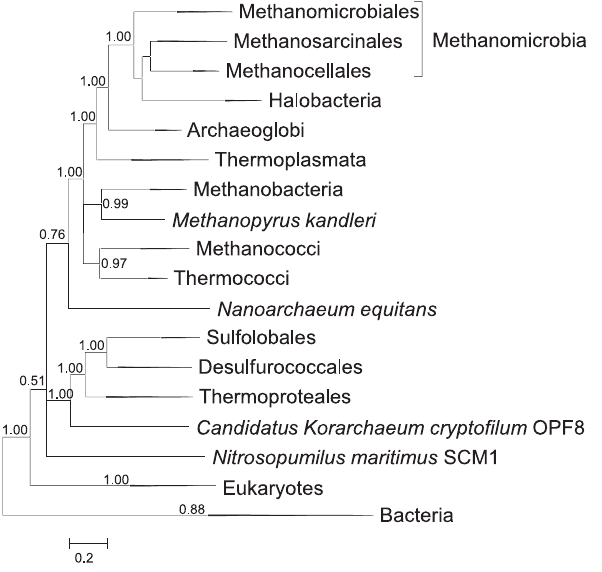
Figure 7. Three-domain phylogenetic tree reconstructed from a concatenated alignment of 32 universal r-proteins. Branches having bootstrap support values less than 0.5 were collapsed.